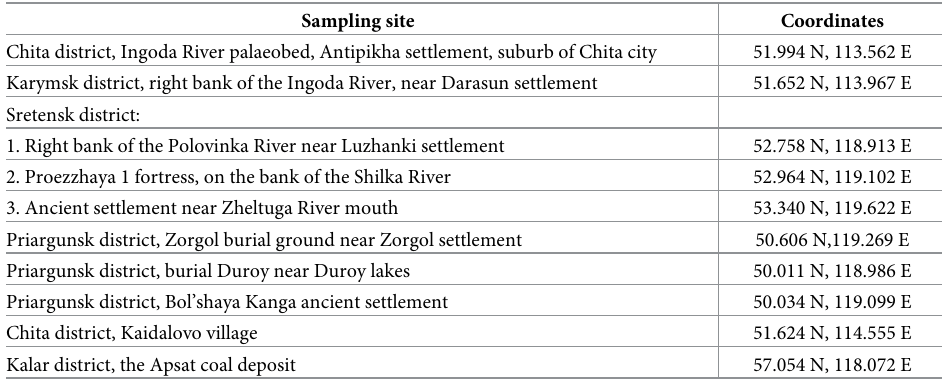
Table 1. Geographical coordinates of the study sites in the